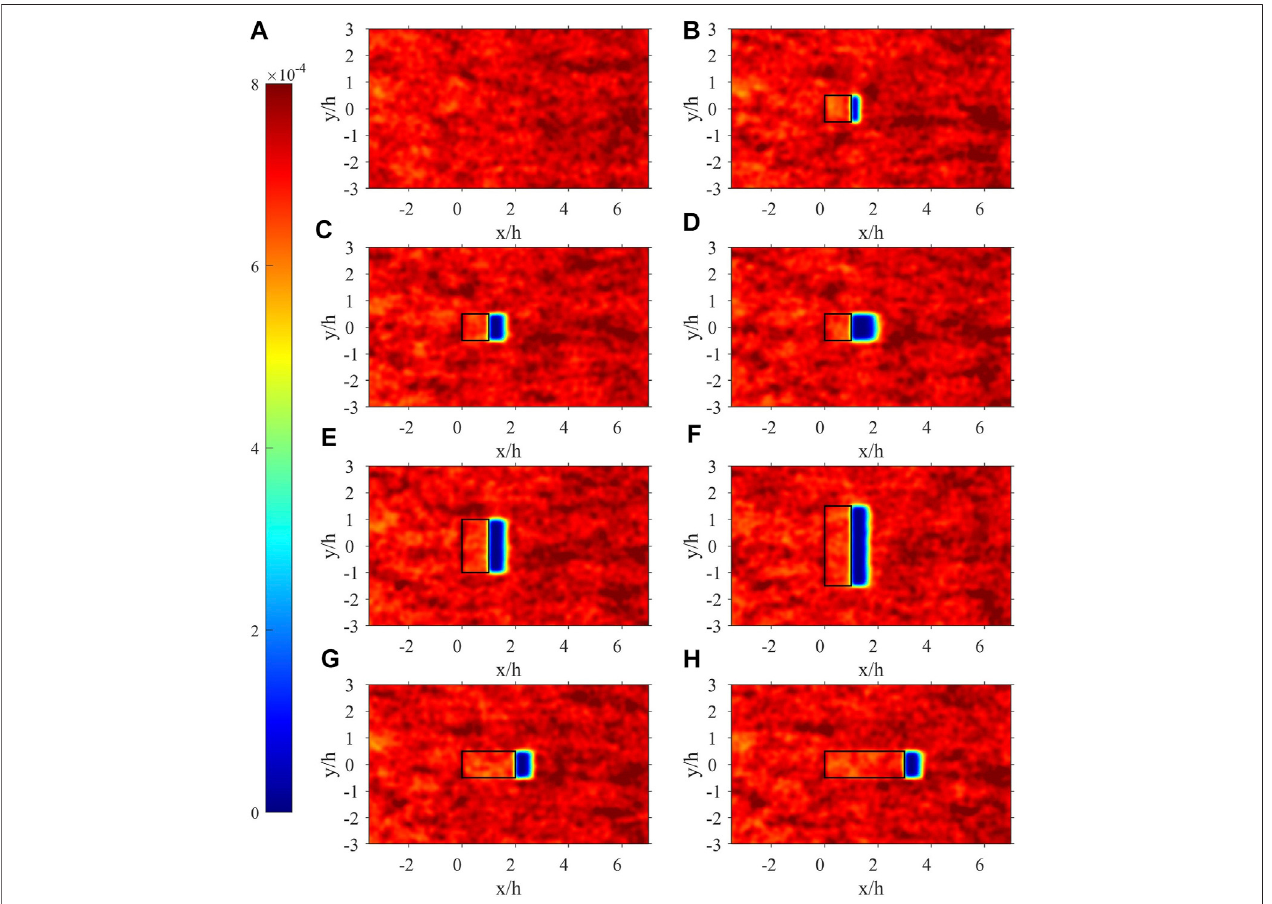
FIGURE 9 | Contour plots of normalized number density of the deposited fi rebrands on the ground (A) with no structure; top face and the ground around single structures with (B) L (cid:3) W (cid:3) H (cid:3) 3 m; (C) L (cid:3) W (cid:3) 3 m, H (cid:3) 6 m; (D) L (cid:3) W (cid:3) 3 m, H (cid:3) 9 m; (E) L (cid:3) 3 m, W (cid:3) H (cid:3) 6 m; (F) L (cid:3) 3 m, W (cid:3) 9 m, H (cid:3) 6 m; (G) L (cid:3) H (cid:3) 6 m, W (cid:3) 3 m; (H) L (cid:3) 9 m, W (cid:3) 3 m, H (cid:3) 6 m.